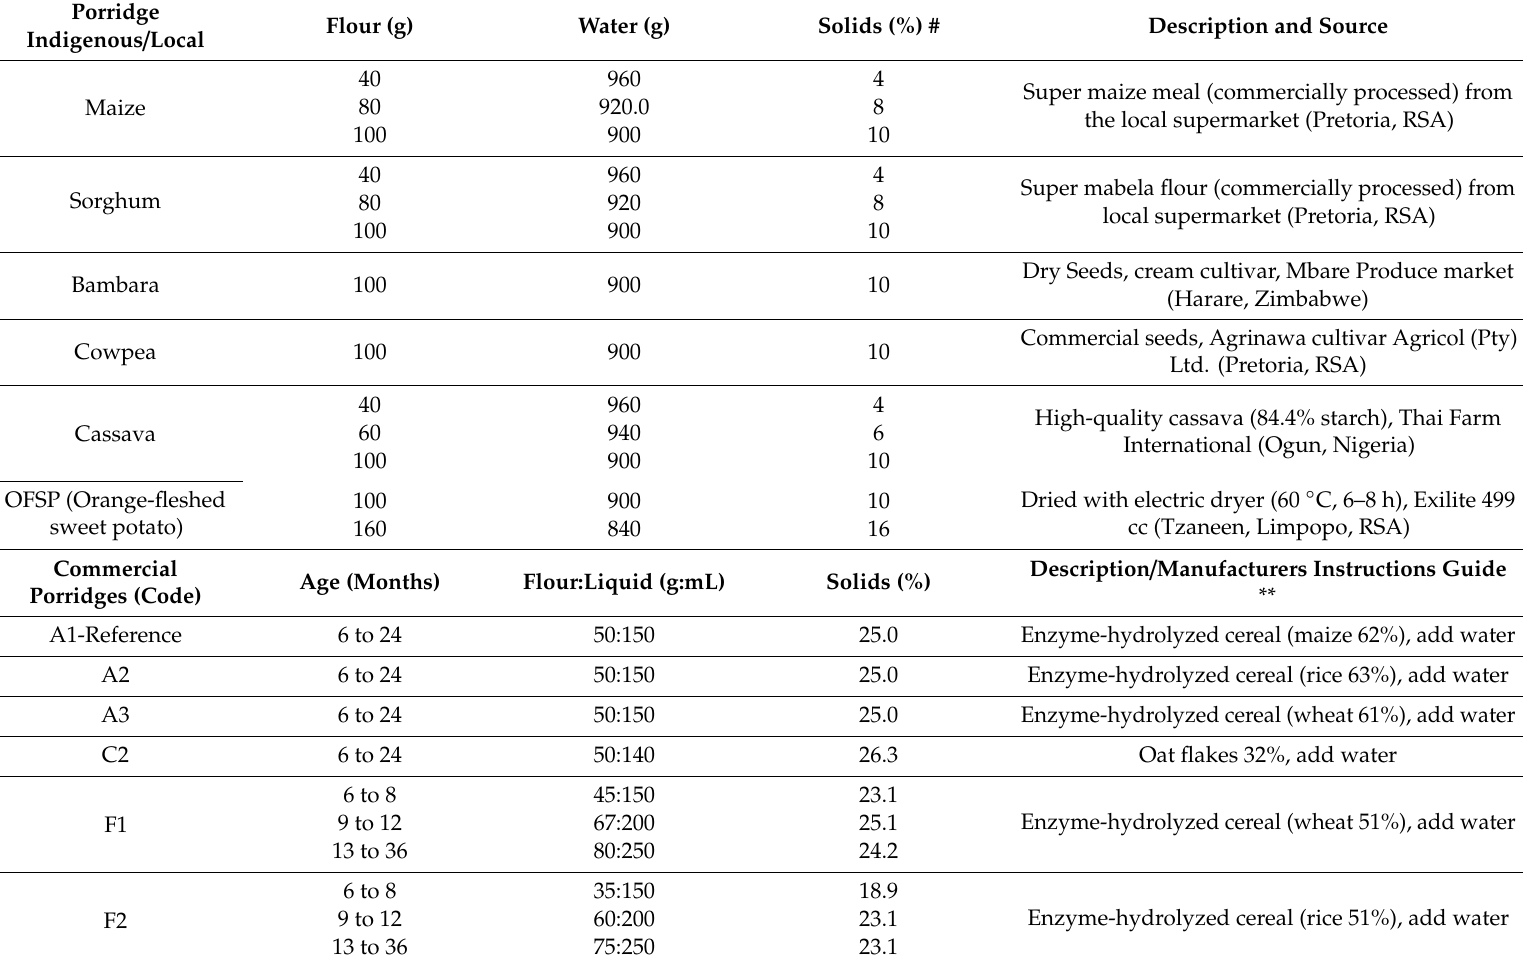
Description and